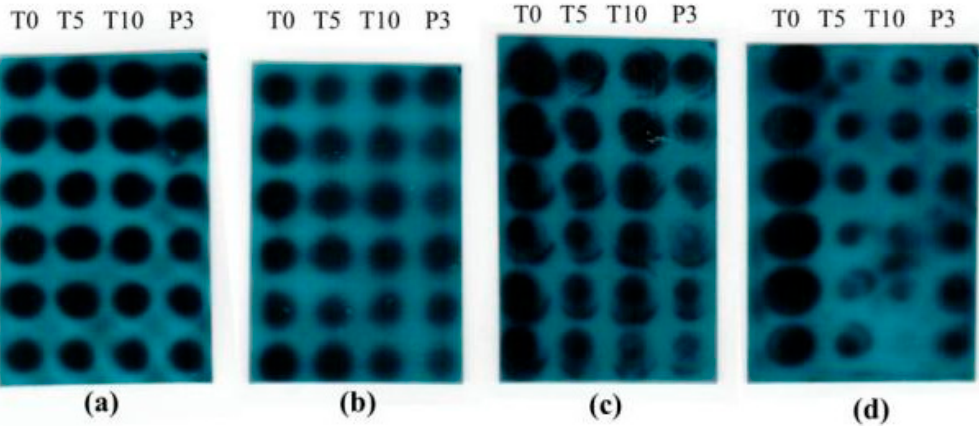
Figure 6. Dot blots of DHBV DNA in duck serum in the OA-4 treatment study. ( a ) 125 mg/kg OA-4 treatment; ( b ) 250 mg/kg OA-4 treatment; ( c ) 500 mg/kg OA-4 treatment; ( d ) 50 mg/kg 3TC treatment.